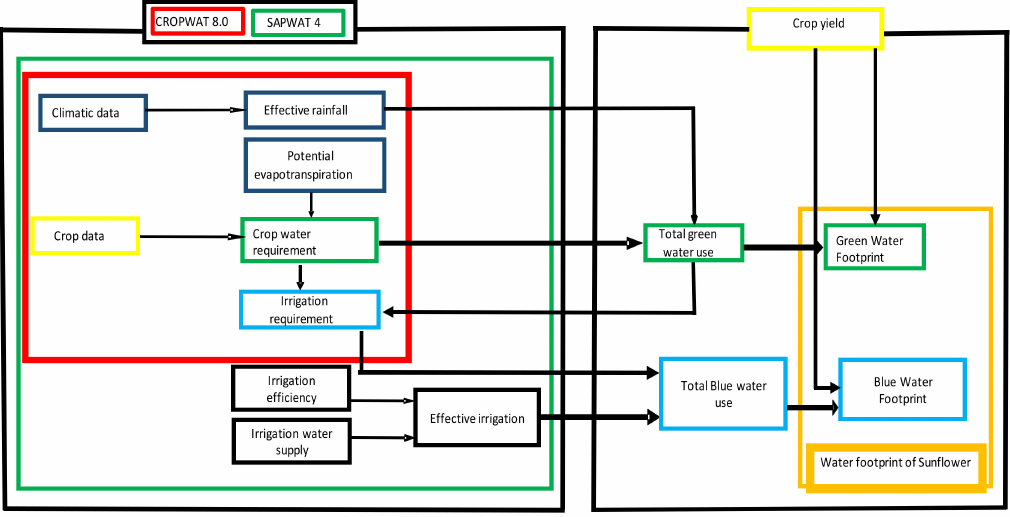
Figure 2. Systematic framework used or water footprint evaluation. Source: Authors’ depiction. Calculate the green water footprint of rain-fed and irrigated sunflower and the blue water footprint of irrigated sunflower only. Using Hoekstra’s method, only the green water footprint (WF green ) and blue